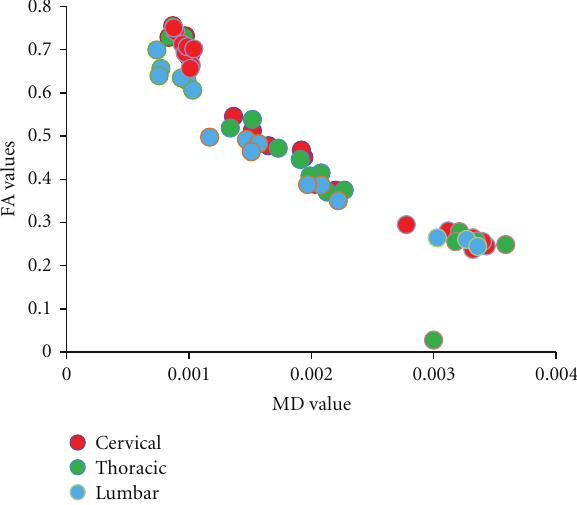
Figure 2: Centroid coordinates for each region of the cord, for each person. Centroid coordinates, which reflect the mean FA and MD for each cluster, remained relatively consistent along the length of the cord, specifically in the white matter